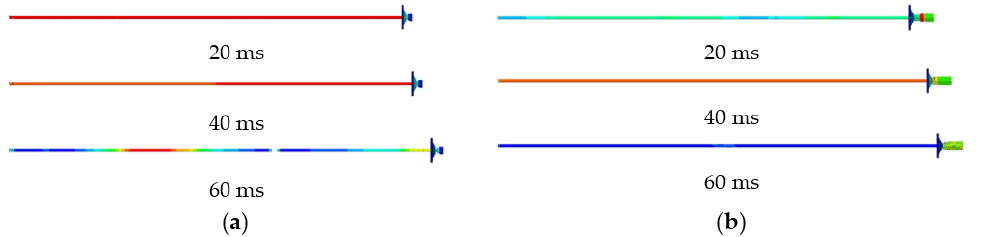
Figure 7. Deformation diagram of anchor rod subjected to impact load. ( a ) Conventional anchors, ( b ) constant resistance energy-absorbing anti-scour anchor.